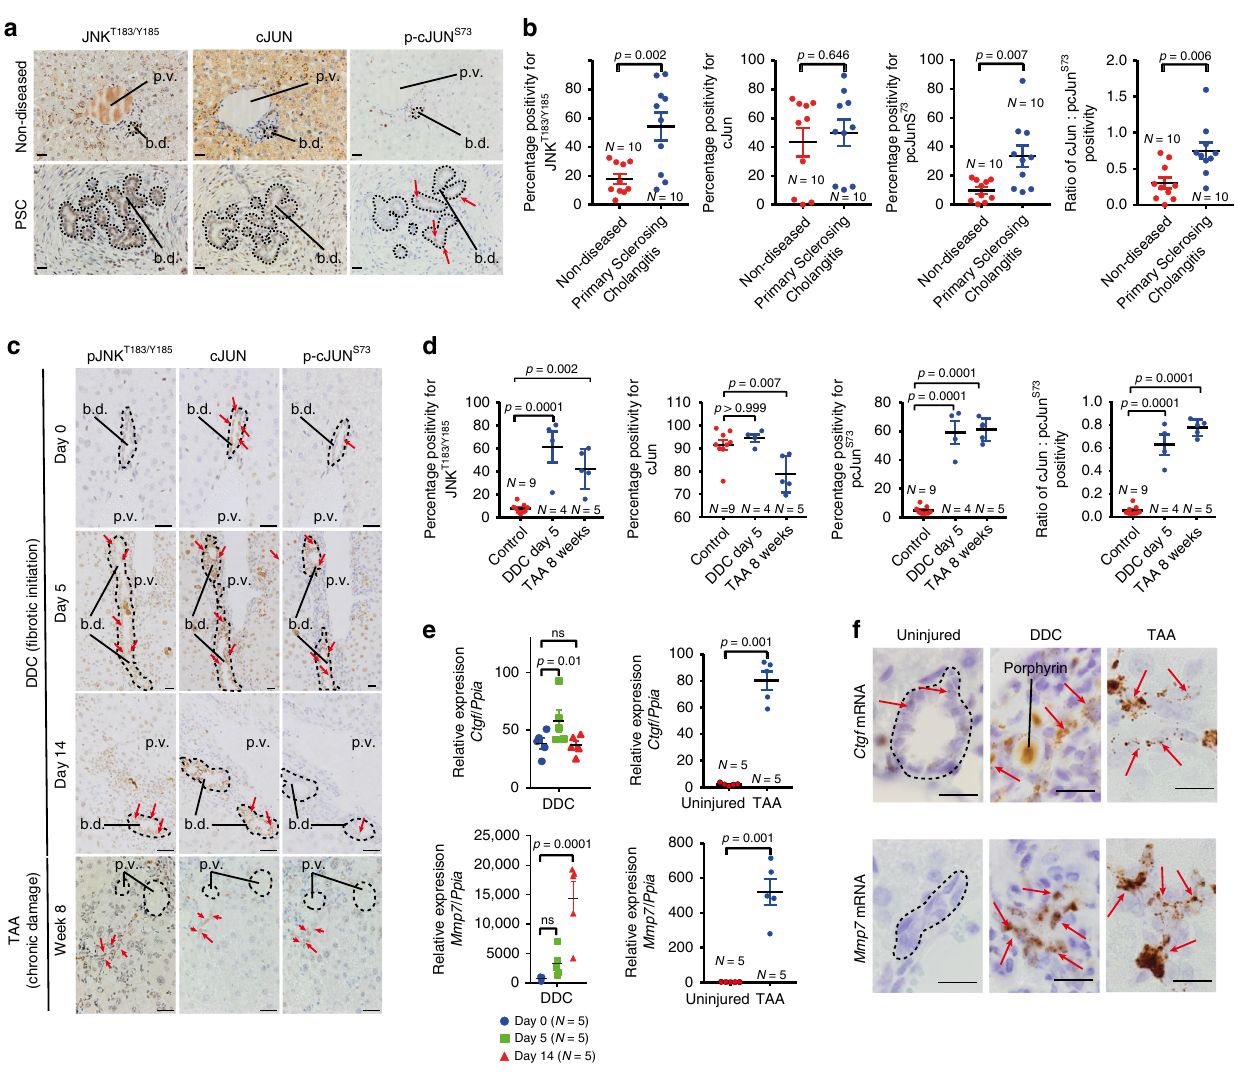
Fig. 1 Activation of the Jnk – Jun signal in biliary disease. a Immunohistochemistry on serial sections of either non-diseased (upper panels) or primary sclerosing cholangitis tissue (bottom panels) stained for phosphorylated JNK T183/Y185 , total c-JUN and phosphorylated c-JUN S73 . Dotted lines demarcate the boundary of bile ducts. Red arrows identify biliary epithelial cells with positive phosphorylated c-JUN S73 expression. b Quanti fi cation of phosphorylated JNK T183/Y185 , total c-JUN or phosphorylated c-JUN S73 and the quanti fi cation of c-JUN:phospho-c-JUN S73 in normal human and primary sclerosing cholangitis tissue. c Immunohistochemistry of phosphorylated JNK T183/Y185 , total c-JUN and phosphorylated c-JUN S73 in a time course of DDC injury to model fi brotic initiation or in established fi brosis induced by treatment with TAA. Red arrows denote positive nuclei. Dotted lines demarcate biliary epithelial cells and bile ducts. d Quanti fi cation of phosphorylated JNK T183/185 , total c-JUN, phosphorylated c-JUN S73 and the ratio of total c-JUN: phosphorylated c-JUN S73 in the DDC and TAA models. e mRNA expression of Wnt-PCP target genes in mice undergoing DDC and TAA-induced biliary injury, normalised to the housekeeping gene, Ppia . f RNAScope of mRNA for Ctgf and Mmp7 in healthy bile ducts and following bile duct injury. Red arrows denote RNAScope positivity. Scale bar = 50 µ m. p.v. — portal vein, b.d. — bile duct. Porphyrin (labelled) accumulation in the duct is a consequence of the DDC model. Source data are provided as a Source Data fi le. In graphs where two groups are included, a Student ’ s t test is used. When comparing multiple groups, a one-way ANOVA with post hoc correction for multiple testing is used. In dot plots, data are presented as mean ± S.E.M. Each data point (N) represents an individual animal or